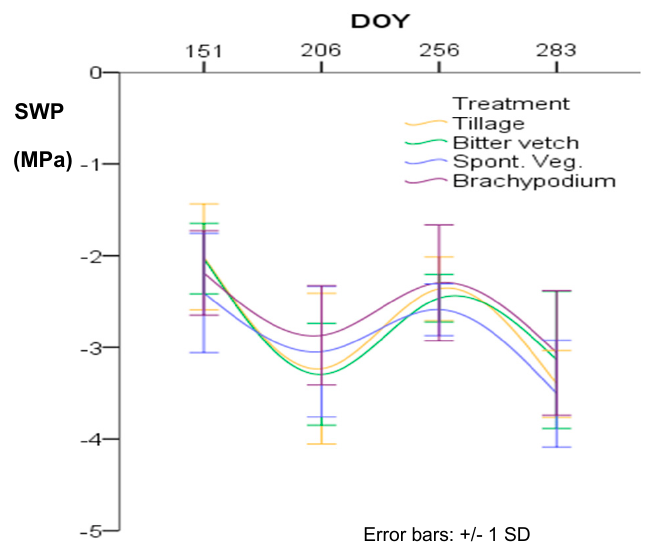
Figure 9. Steam water potential (SWP) in four moments of the crop season for the different treatments. DOY: day of the year. No statistically significant differences were found between treatments at p < 0.05 according to Tukey’s test (N = 12).